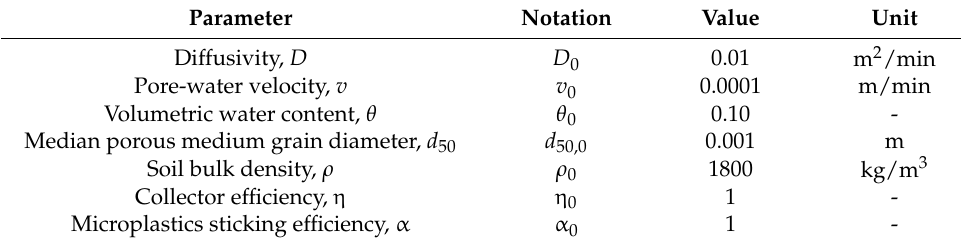
Table 1. Parameter values for the transport simulation of